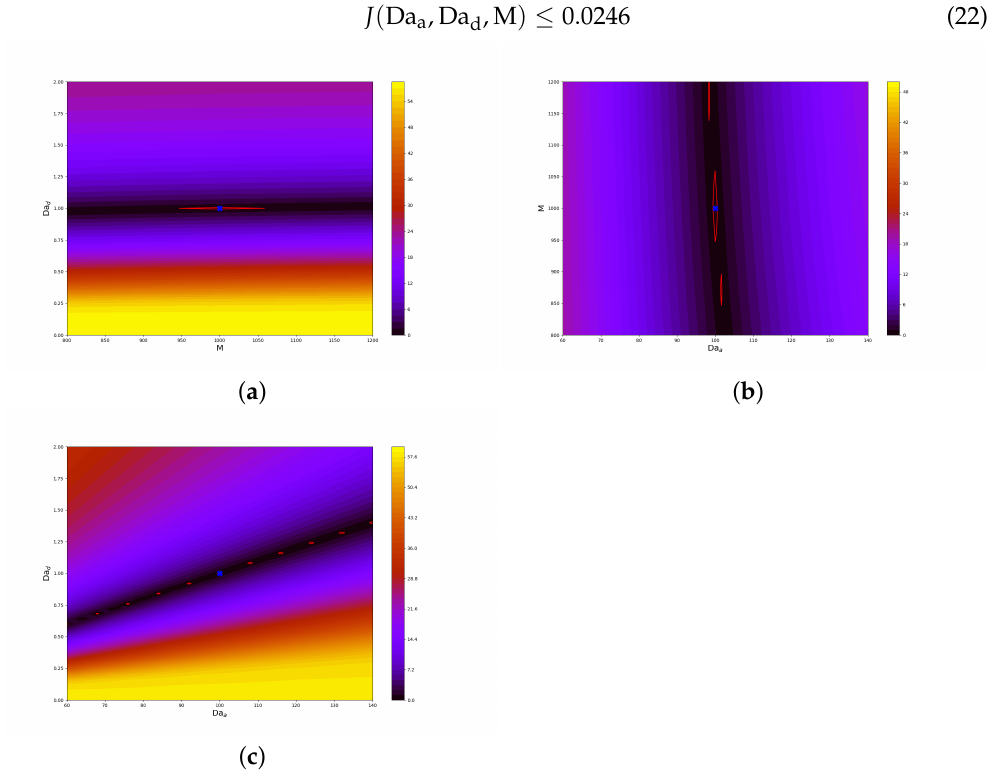
Figure 9. Calculations for fixed: ( a ) Da a , ( b ) Da d , ( c )